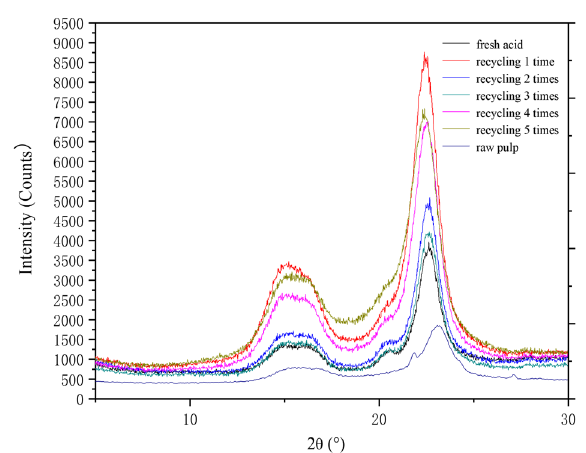
Figure 3: XRD patterns of the raw material and hydrolyzed cellulose under a varied number of waste cycles.